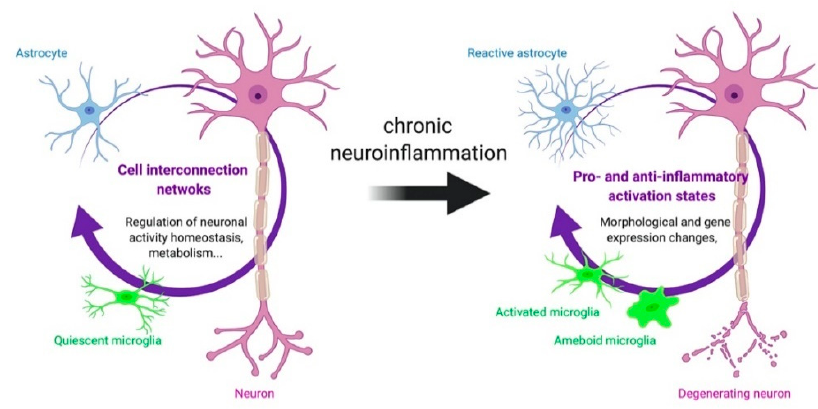
Figure 1. Interactions between neurons, astrocytes and microglia in health and disease. In a healthy brain, the connectivity between neurons, astrocytes and microglia maintains homeostasis. In brain disease, specific morphological and functional alterations of glial cells could lead to brain degeneration.